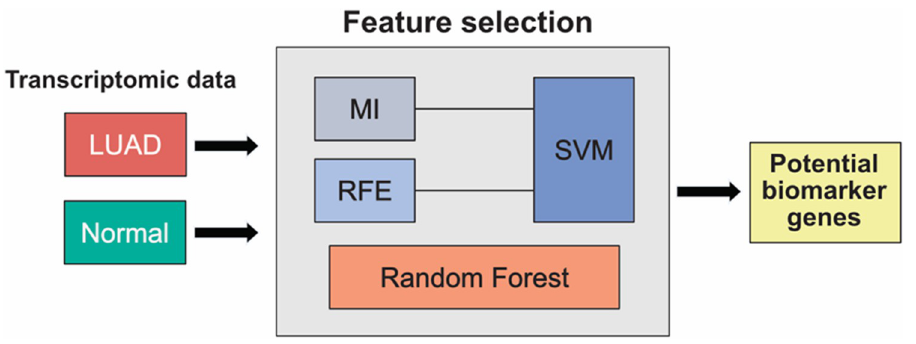
Fig 1. An overview of our proposed